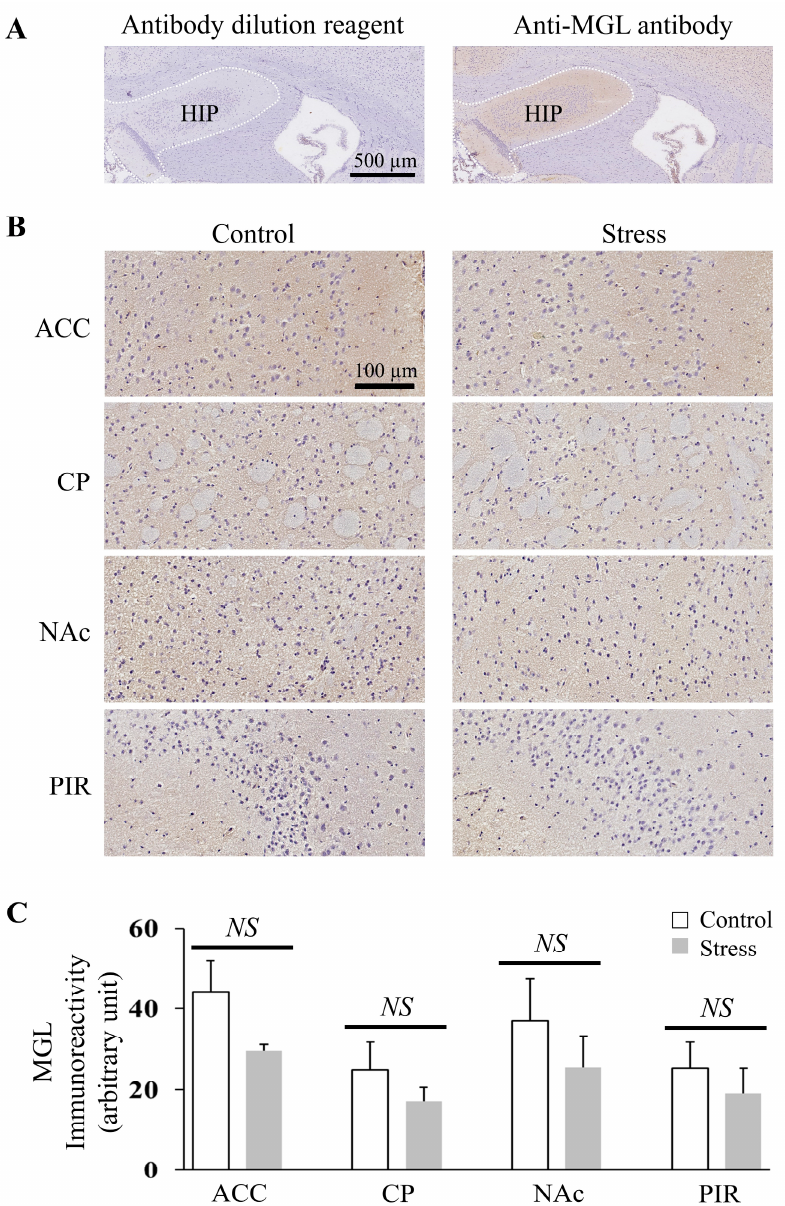
Figure 4. MGL immunoreactivity in the ACC, CP, Nac, and PIR was not different between control and stressed mice. ( A ) Immunohistochemical staining for the validation of MGL in mice HIP (the white dotted line circled part). The left is the result of the antibody dilution reagent and the right is the result of MGL (500X) (scale bar: 500 µ m). ( B ) Representative MGL-immunoreactive result of ACC, CP, NAc, and PIR in the control and stressed mice sections (scale bar: 100 µ m). ( C ) Quantification comparison of the immunohistochemical expression of MGL in the ACC, CP, NAc, and PIR between control and stressed mice. Histograms represent the mean + SEM (the number of mice in each group was three). Two-tail t-test was performed. NS: p -value >